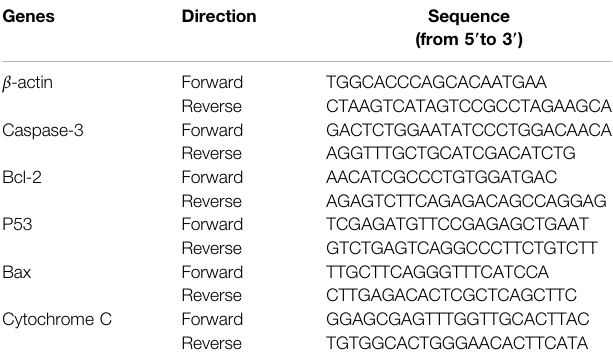
TABLE 1 | Primer sequences used in RT-qPCR. Genes